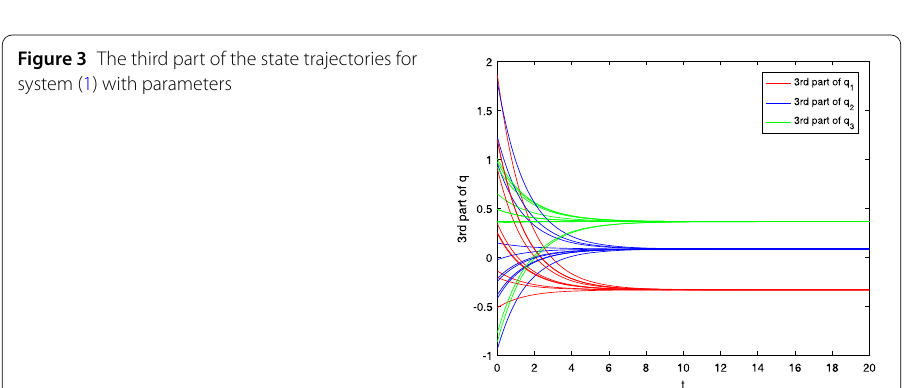
b 21 = 0.05 + 0.01 ı + 0.01 j + 0.01 κ